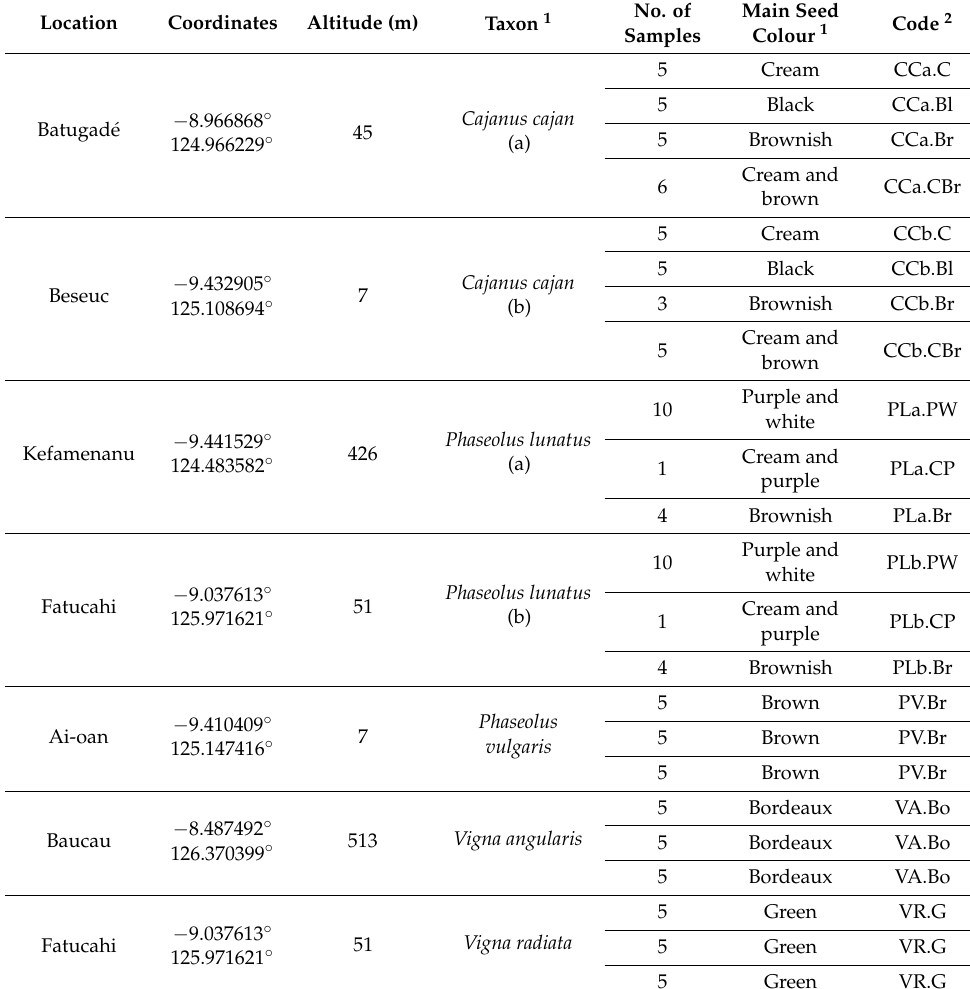
Table 1. Studied bean species: place of collection, scientific name, number of samples, main seed colour, and